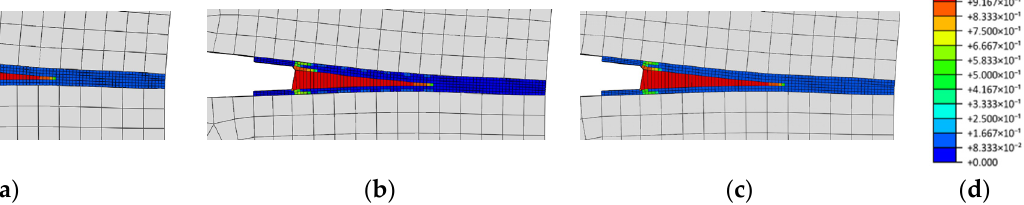
Figure 8. Final matrix damage field distribution for ( a ) implicit, ( b ) explicit, and ( c ) ITE for the CT test, ( d ) matrix damage scale.